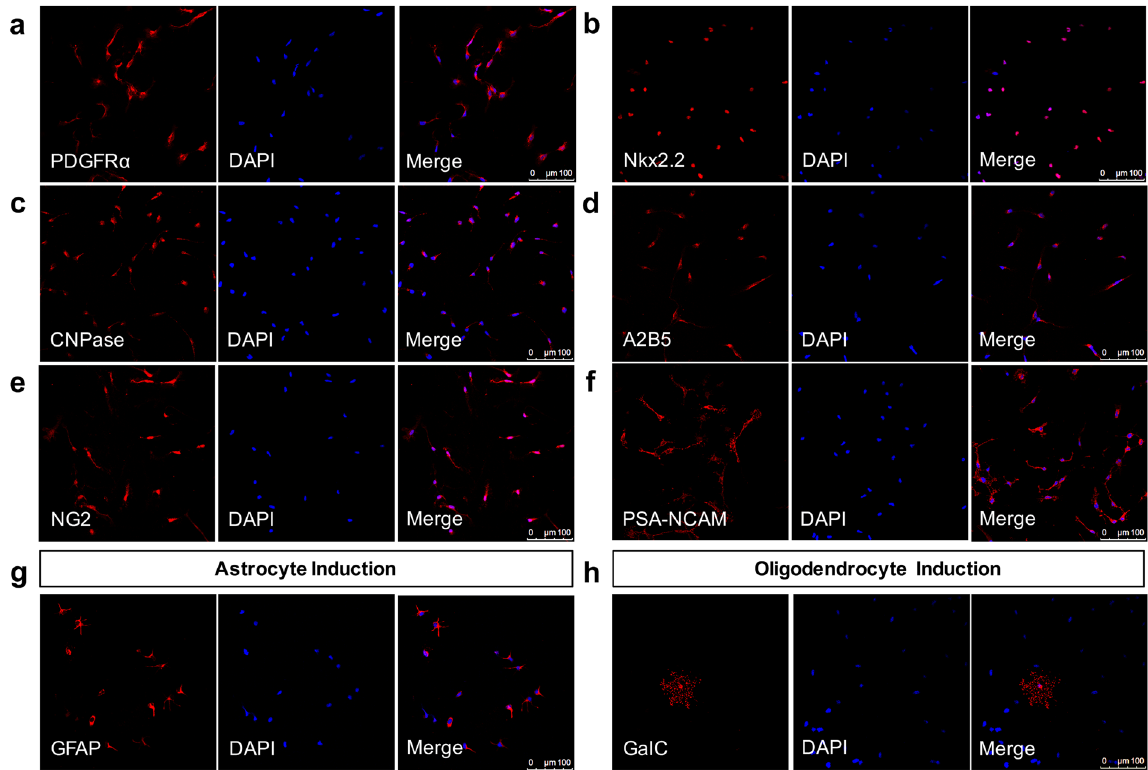
Figure 1. CD140 + hOPCs express common OPC markers and differentiate into oligodendrocytes and astrocytes in vitro . hOPCs were isolated from 19–22 week fetal human tissue by immunomagnetic purification using anti-CD140 beads. When cultured in the presence of PDGF and FGF for 7 days, these cells expressed a variety of known OPC markers, including ( a ) PDGFR α , ( b ) Nkx2.2, ( c ) CNPase, ( d ) A2B5, ( e ) NG2, and ( f ) PSA-NCAM. ( g ) When exposed to bone morphogenic protein 4 (BMP-4) for 7 days, cells differentiated into GFAP + astrocytes. ( h ) When exposed to triiodothyronine/thyroxine (T 3 /T 4 ) for 10 days, these cells differentiated into GalC +